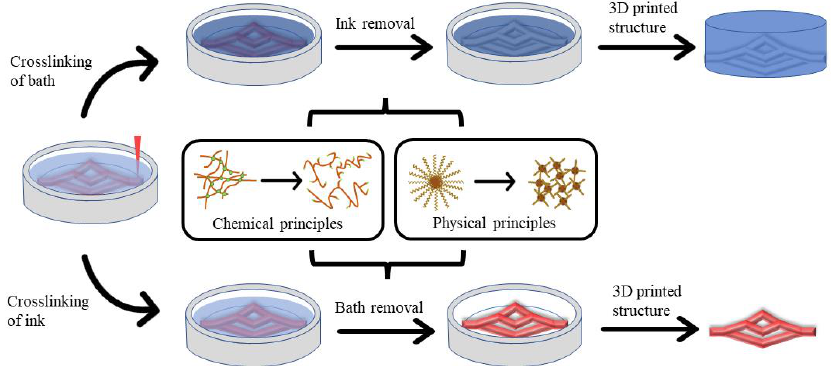
Figure 1. Overview of the main application scenarios of sacrificial biomaterials based on physical and chemical polymer crosslinking principles in 3D bioprinting. Top: The use of a physical crosslinked sacrificial polymer to form a tubular vascular network. Bottom: The use of a chemical crosslinked sacrifice polymer as a support bath to print the required vascular network.